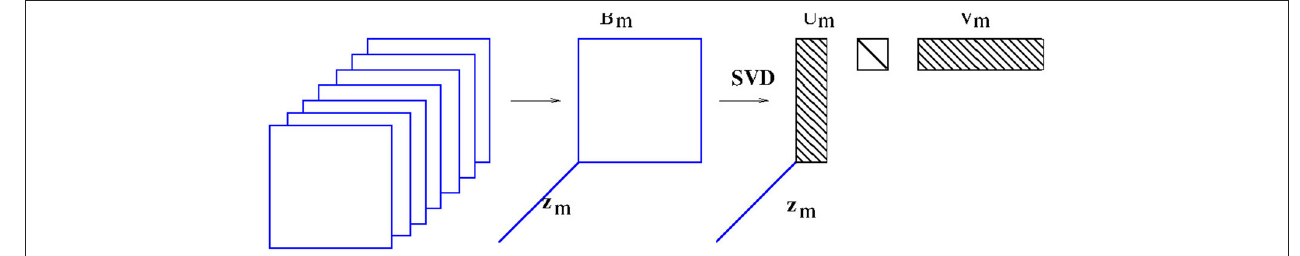
FIGURE 4 | Tucker-to-canonical decomposition for a small core tensor, see Remark